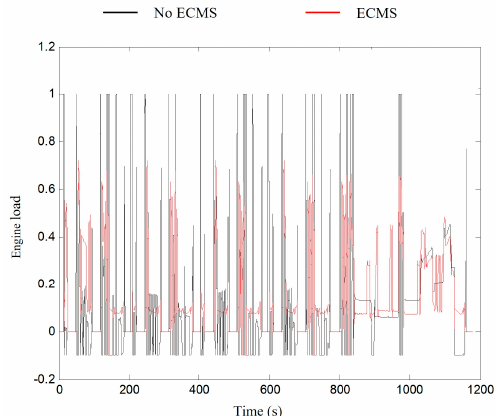
Figure 8. Output torque of the motor after ECMS control strategy participates in NEDC test conditions.